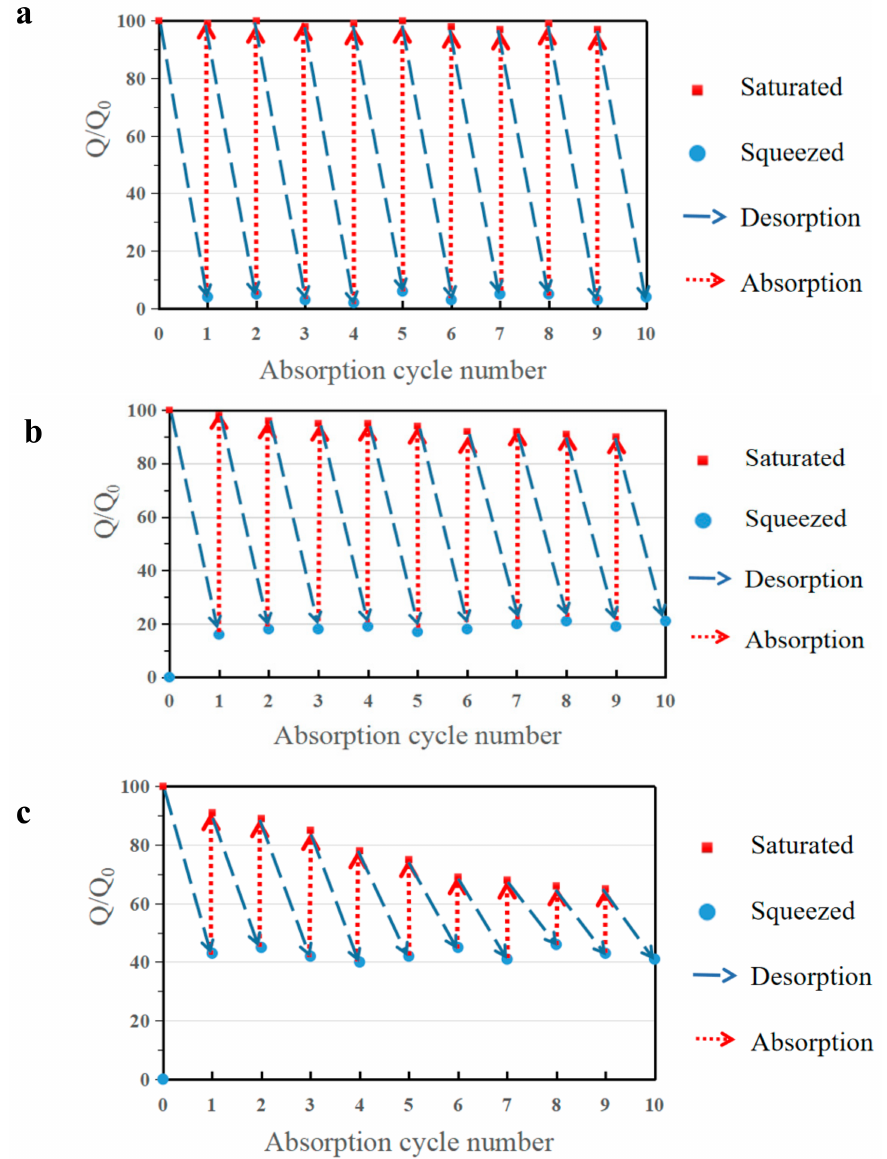
Figure 8. ( a ) Oil recovery ability of b-MG 20 TPA over 10 cycles of absorption and desorption by distillation of hexane. Ethanol was selected as the model oil to test the distillation. Demonstration of expelling absorbed hexane by squeezing from ( b ) b-MG 20 TPA and ( c ) r-MG 20 TPA. Oil recovery ability of b-MG 20 TPA and r-MG 20 TPA over 10 cycles of absorption and desorption by mechanical